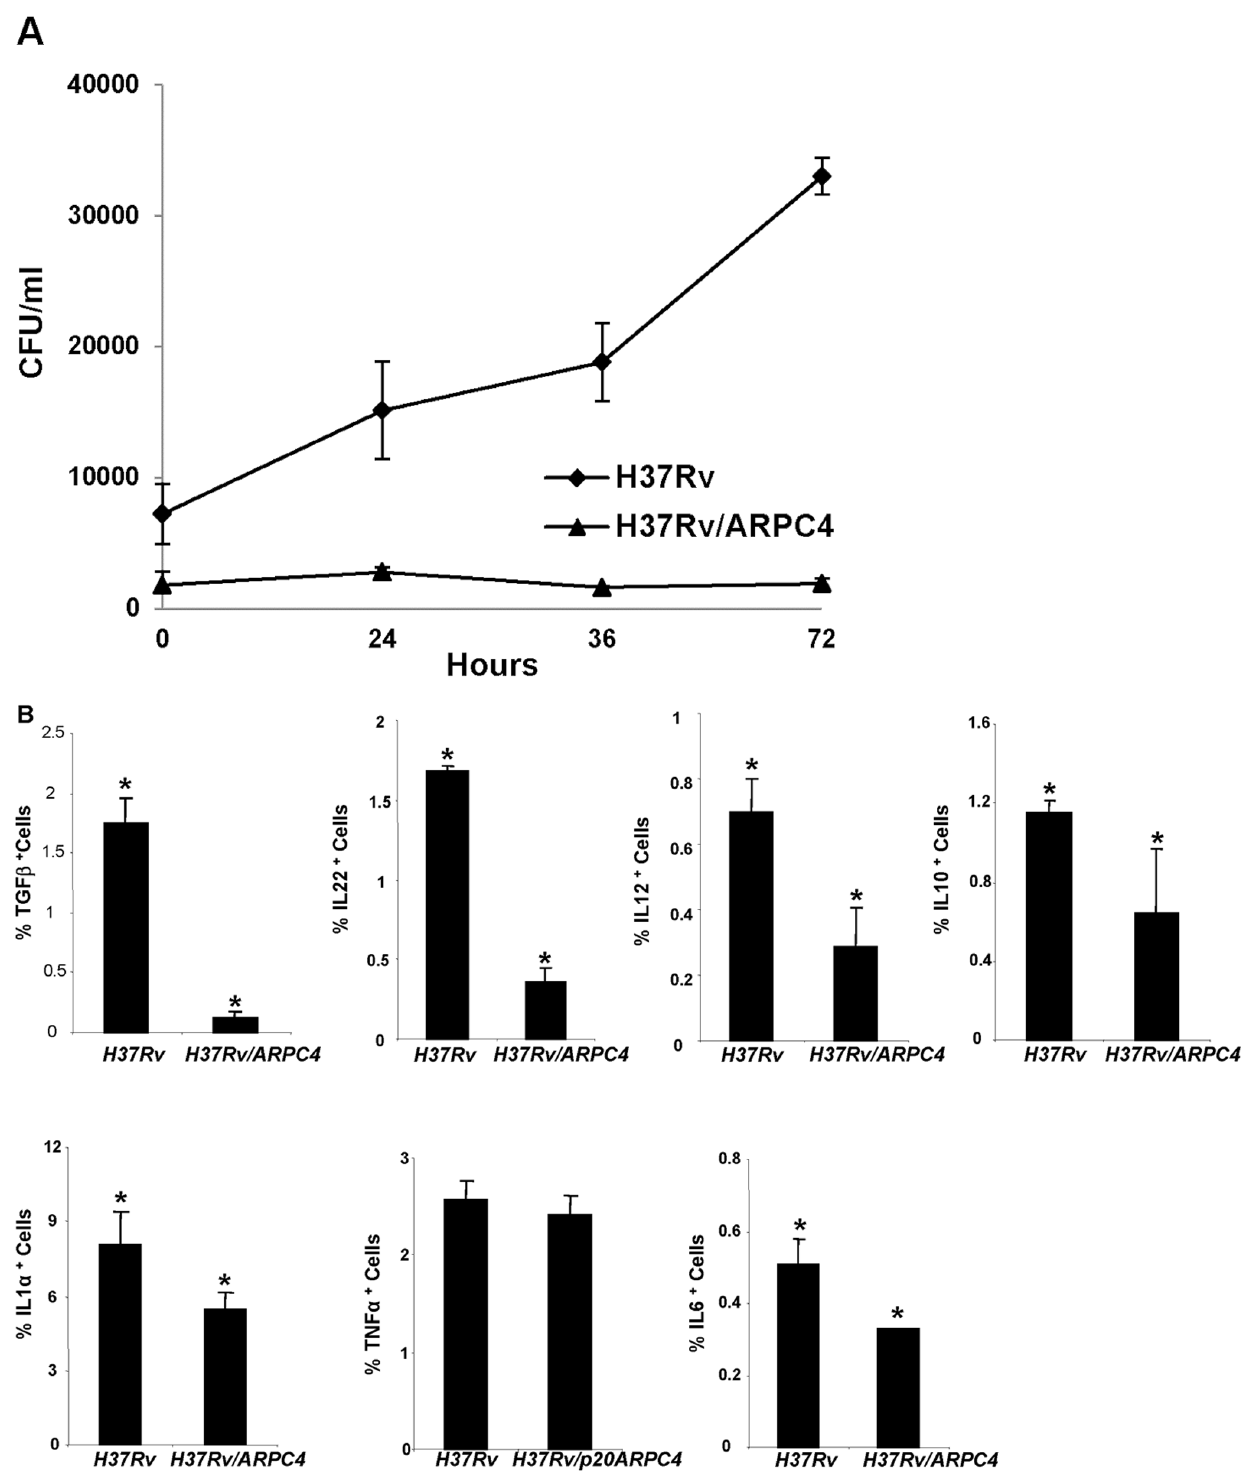
Figure 2. Infection of murine macrophages with H37Rv/ARPC4 mycobacterial strain. A. CFU count showing the bacterial load in macrophages infected with H37Rv/ARPC4 and wild-type H37Rv. The infected macrophages were lysed at 0, 24, 48 and 72 hour time-points post- infection and four dilutions of the released mycobacterial cells were plated on 7H11 agar plates. CFU were counted and recorded after 15 days of plating. B. The plots show the cytokine milieu in macrophages. Macrophages were cultured and activated with 50 ng/ml phorbol 12-myristate 13- acetate (PMA) and 500 ng/ml ionomycin overnight, and 10 m g/ml Brefeldin A was added during the last 6 hours of culture. Cells were then intracellularly stained with anti-IL22, -TGF b , -IL10, -IL12, -IL6, TNF a , and IL1 a antibodies. Cells were acquired by flow cytometer. Data are shown as mean 6 STDEV and Student’s t-test was applied for estimating significance between two groups and the * denotes p , 0.01.